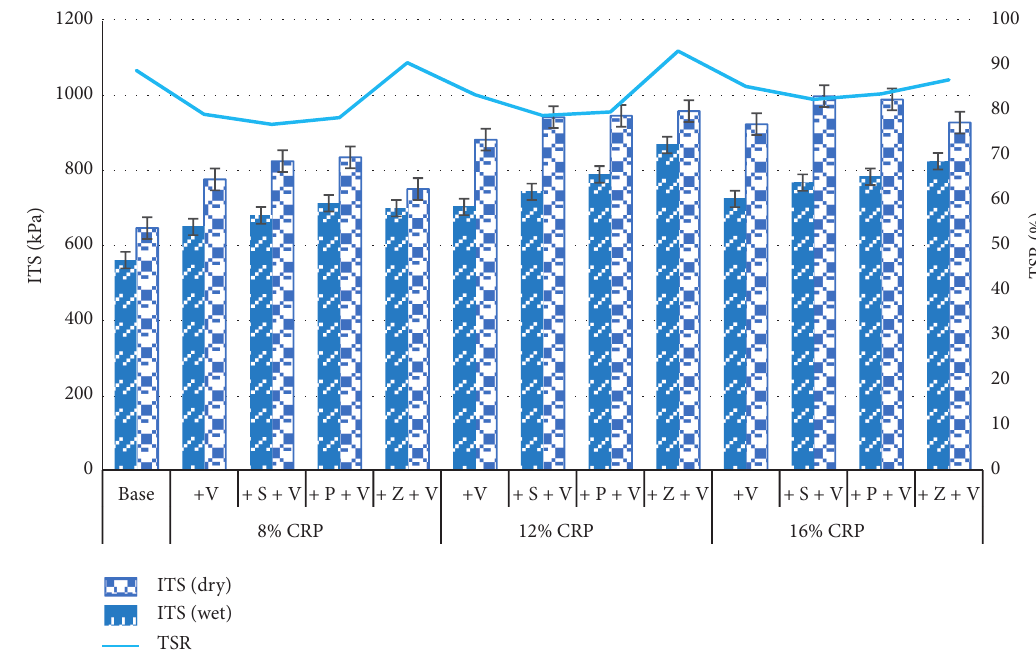
Figure 5: ITS and TSR of various mixtures.